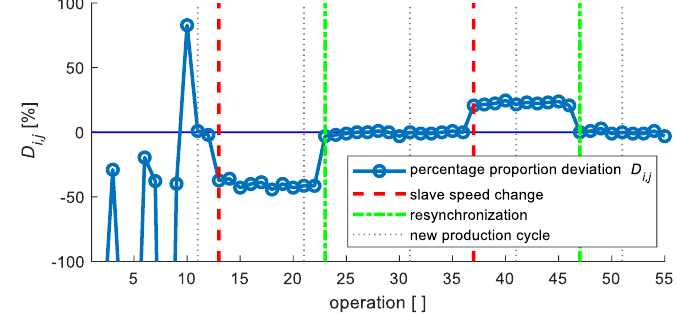
Figure 8. Percentage proportion deviation without feedforward synchronization — Experiment 2a.